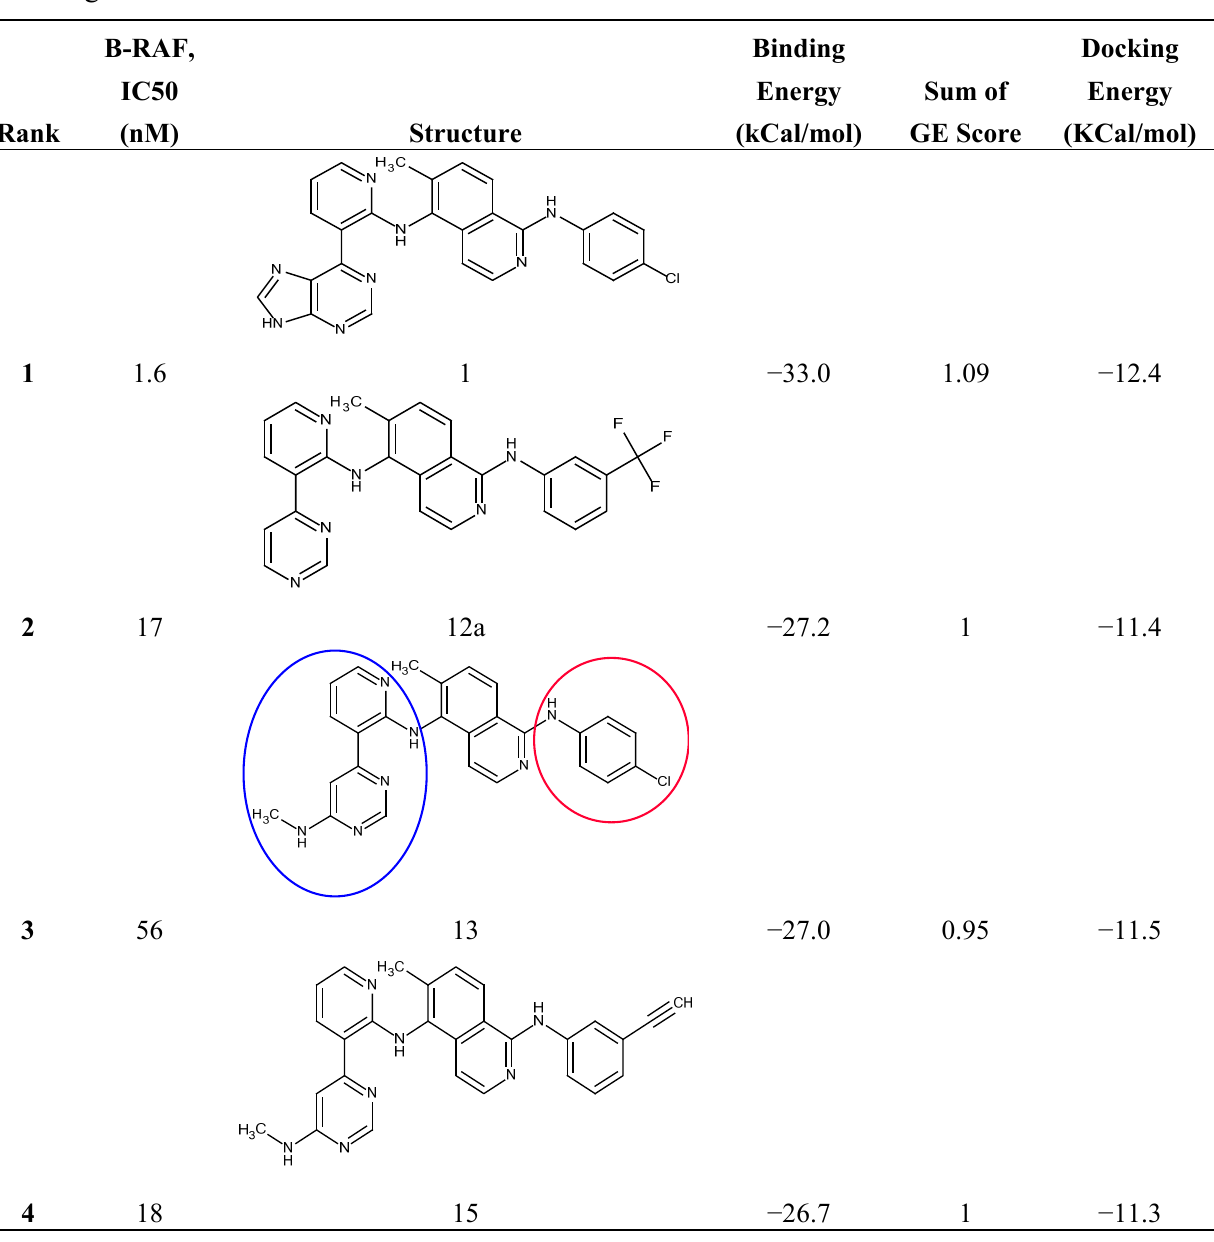
Table 2. Ranking of aminoisoquinoline series of compound after optimization. The ellipses define fragments of for each site in Compound 13 ; blue for fragment 1 and red for fragment